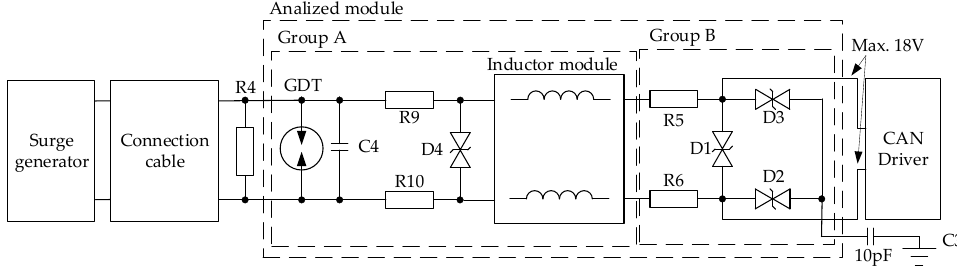
Figure 3. Diagram of the analyzed circuit.